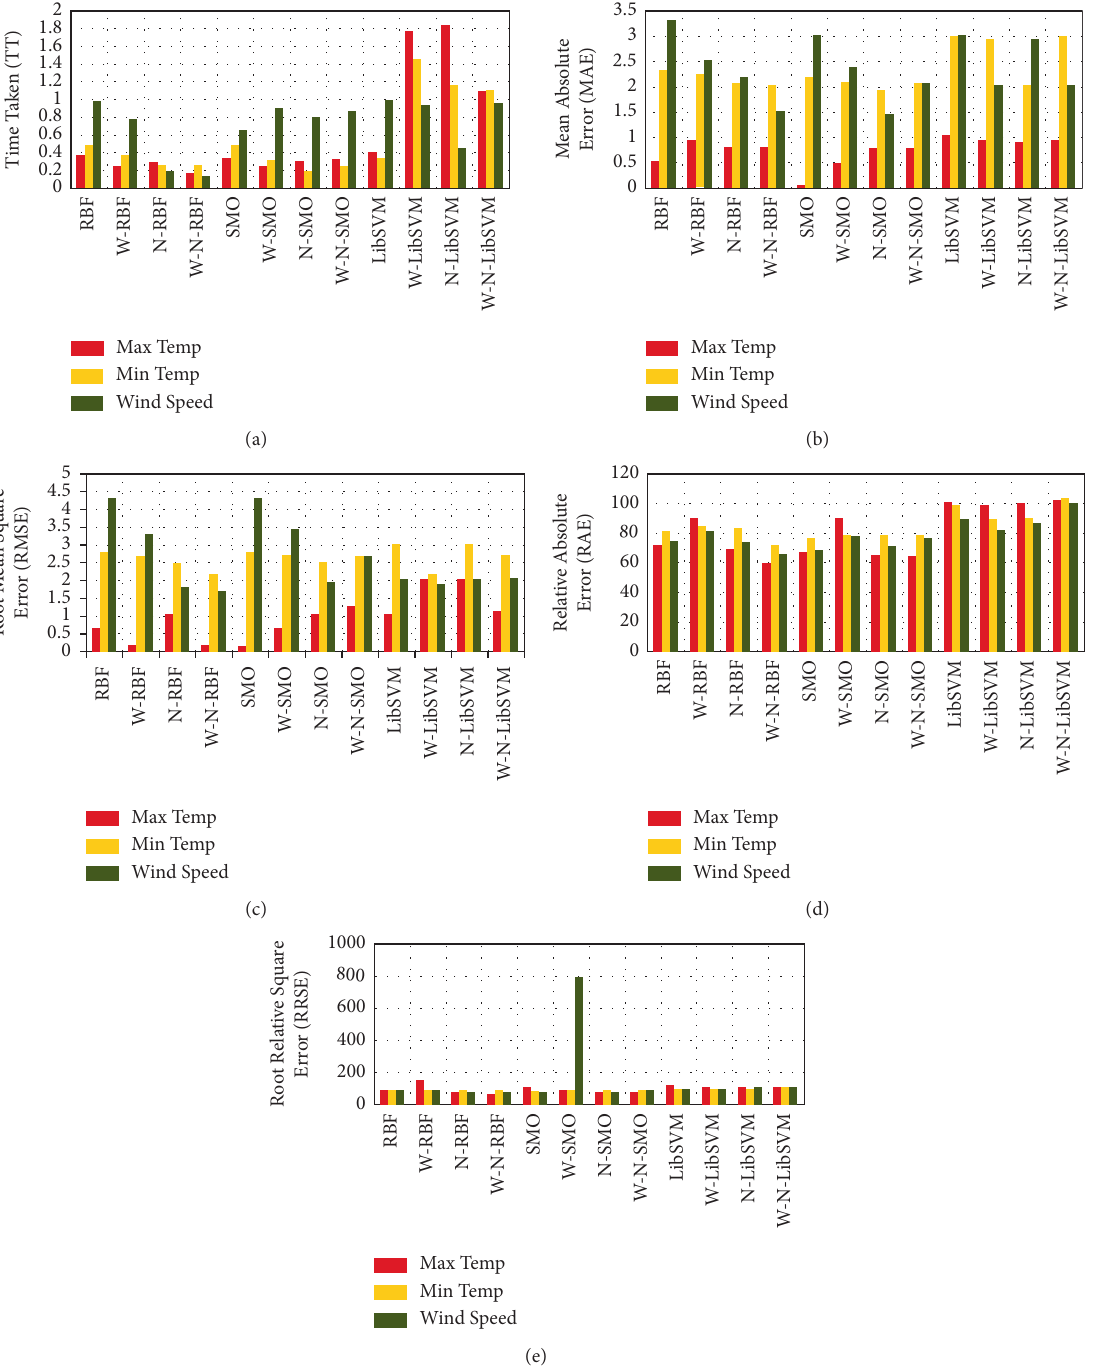
Figure 8: Comparison plot of forecasting errors for Mumbai data. (a) TT comparison. (b) MAE comparison. (c) RMSE comparison. (d) RAE comparison. (e) RRSE